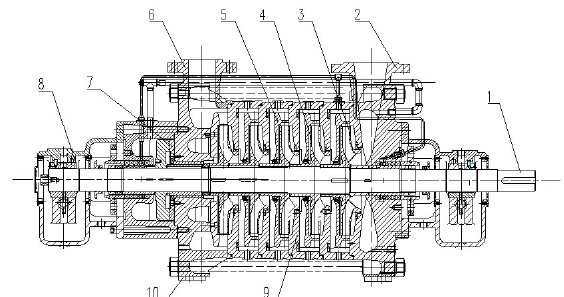
Figure 1. Structure of the five-stage centrifugal pump with 1. shaft, 2. suction, 3. first-stage impeller, 4. second-stage impeller, 5. vaned-diffuser, 6. discharge, 7. balance disc, 8. bearing seat, 9. middle part, and 10. base.